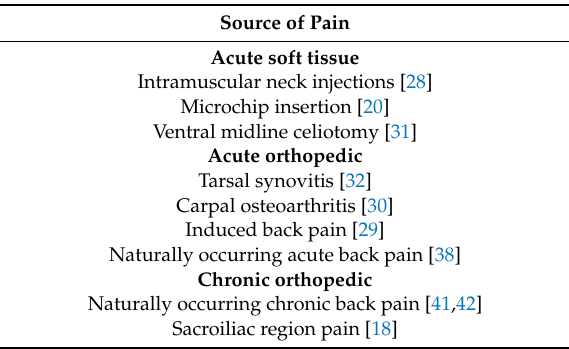
Table 14. Pain sites and conditions with reported MNTs.